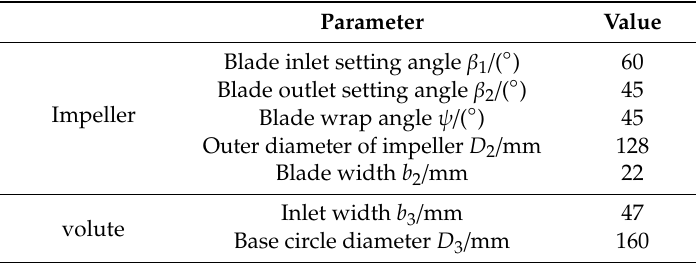
Figure 1. Sketch of the model: ( a ) calculation domains; ( b ) impeller model. Table 1. Geometric dimensions of the impeller and volute.